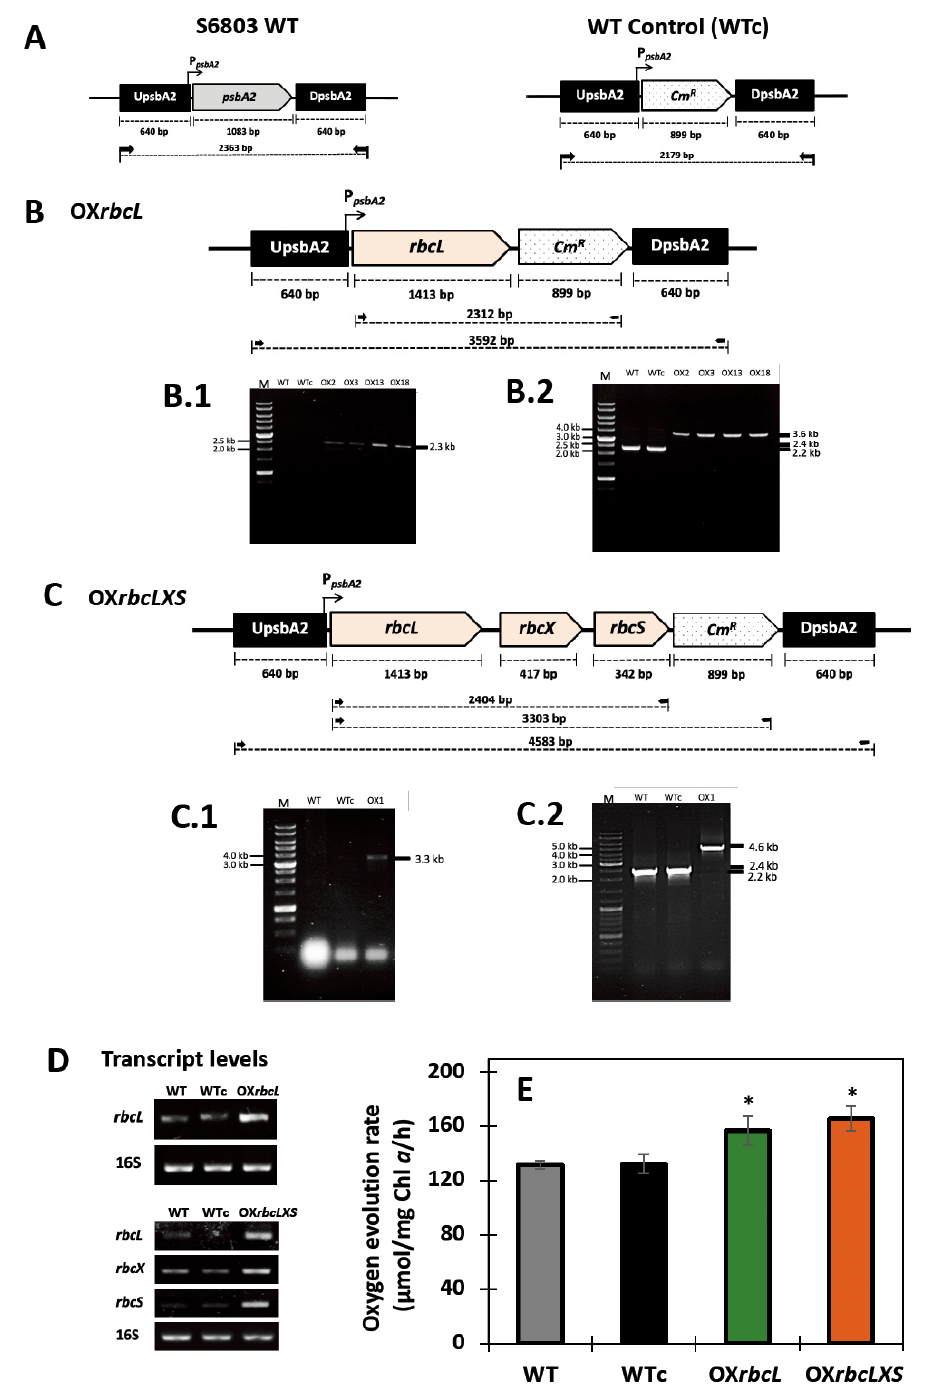
Figure 2. Genomic maps, transcript levels, and oxygen evolution rates of Synechocystis sp. PCC 6803 strains. The three engineered strains are ( A ) wild type control (WTc), ( B ) OX rbcL , and ( C ) OX rbcLXS . Confirmations of the corrected integration and location of each gene fragment into the Synechocystis genome were performed by PCR analysis using various pairs of specific primers (shown in Supple- mentary Information, Table S1). ( A ) The double homologous recombination of Cm R gene occurred between the conserved sequences of psbA2 gene in WTc when compared to WT. For ( B ) OX rbcL strain; Lane M: GeneRuler DNA ladder (Fermentus); ( B.1 ) PCR products using rbcL_F and CM_R primers, Lanes WT and WTc: Negative control using WT and WTc as template, respectively, Lanes OX2, OX3, OX13, and OX18: four clones no. 2, 3, 13, and 18 containing a 2.3 kb fragment of rbcL - Cm R ; ( B.2 ) PCR products using UppsbA2_F and DSpsbA2_R primers, Lanes WT and WTc: Negative controls of a 2.4 kb fragment in WT and a 2.2 kb fragment in WTc, respectively, Lanes OX2, OX3, OX13, and OX18: four clones no. 2, 3, 13, and 18 containing a 3.6 kb fragment of UpsbA2 - rbcL - Cm R - DpabA2 . For ( C ) OX rbcLXS strain; Lane M: GeneRuler DNA ladder (Fermentus); ( C.1 ) PCR products using rbcL_F and CM_R primers, Lanes WT and WTc: Negative control using WT and WTc as tem- plate, respectively, Lanes OX1: one clone no. 1 containing a 3.3 kb fragment of rbcL-rbcX-rbcS-Cm R ;